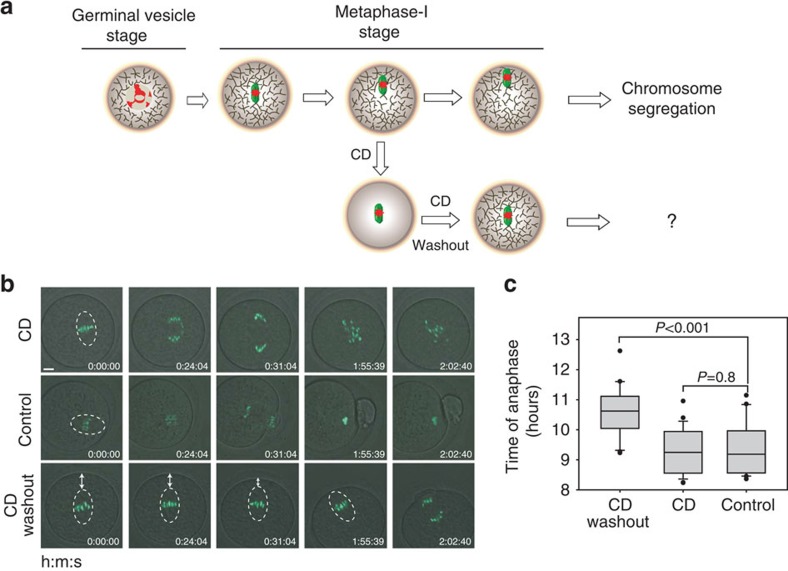
SPC assay I.(a) Two hours after GVBD, maturing oocytes were transferred into a medium containing 0.5 μg ml−1 of CD. At the expected time of chromosome segregation (7 h after GVBD), oocytes expressing H2B-EGFP were washed out from CD and transferred to the microscope for 4D live-cell imaging to record the time of anaphase. (b) Time-lapse imaging of chromosome segregation in control, CD-treated and CD-treated washout oocytes. Scale bar, 10 μm. (c) Time of chromosome segregation (GVBD-anaphase) in CD-treated (three independent experiments, n=24, P<0.001), CD-treated washout (three independent experiments, n=20, P=0.8) and control oocytes (three independent experiments, n=20). Data are mean, with error bars displaying s.d. P-values were calculated with Student's test (nonparametric test, two tailed).